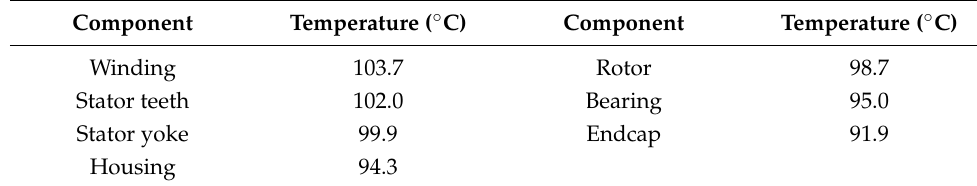
Table 4. Temperature under healthy